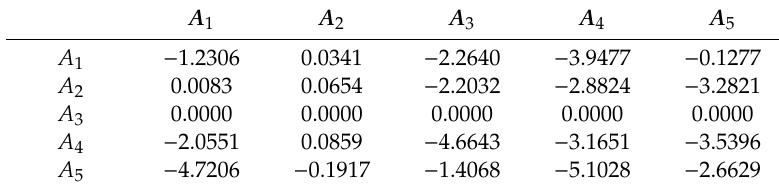
Table 17. Relative prospect dominance ϕ 3 .